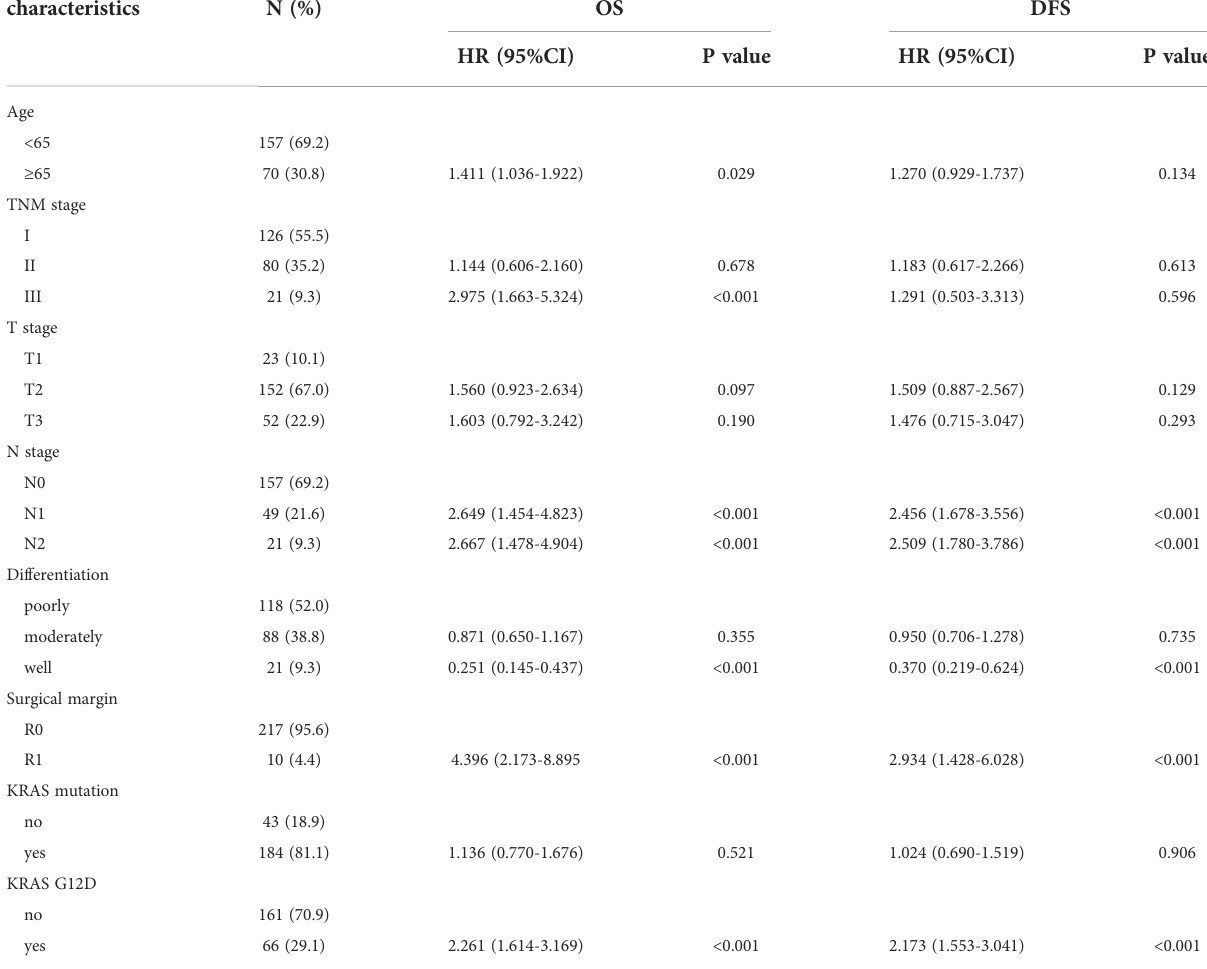
TABLE 4 Multivariate analysis of factors affecting patients ’ OS and DFS in pancreatic ductal adenocarcinoma.